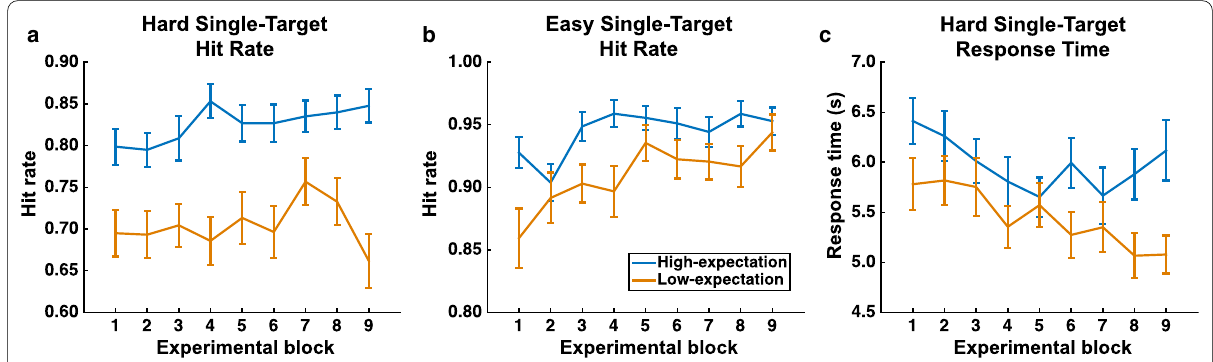
Fig. 4 Analysis of the significant effects of high-expectation (blue) versus low-expectation (orange) on hit rate and response time as a function of experimental block to examine the evolution of the effect over time. The difference between groups was present at the beginning of the experiment and remained present over the course of the experiment for a easy single-target hit rate, b hard single-target hit rate, and c hard single-target response time. The group x block interaction effect was not significant for all three measures. Error bars depict the